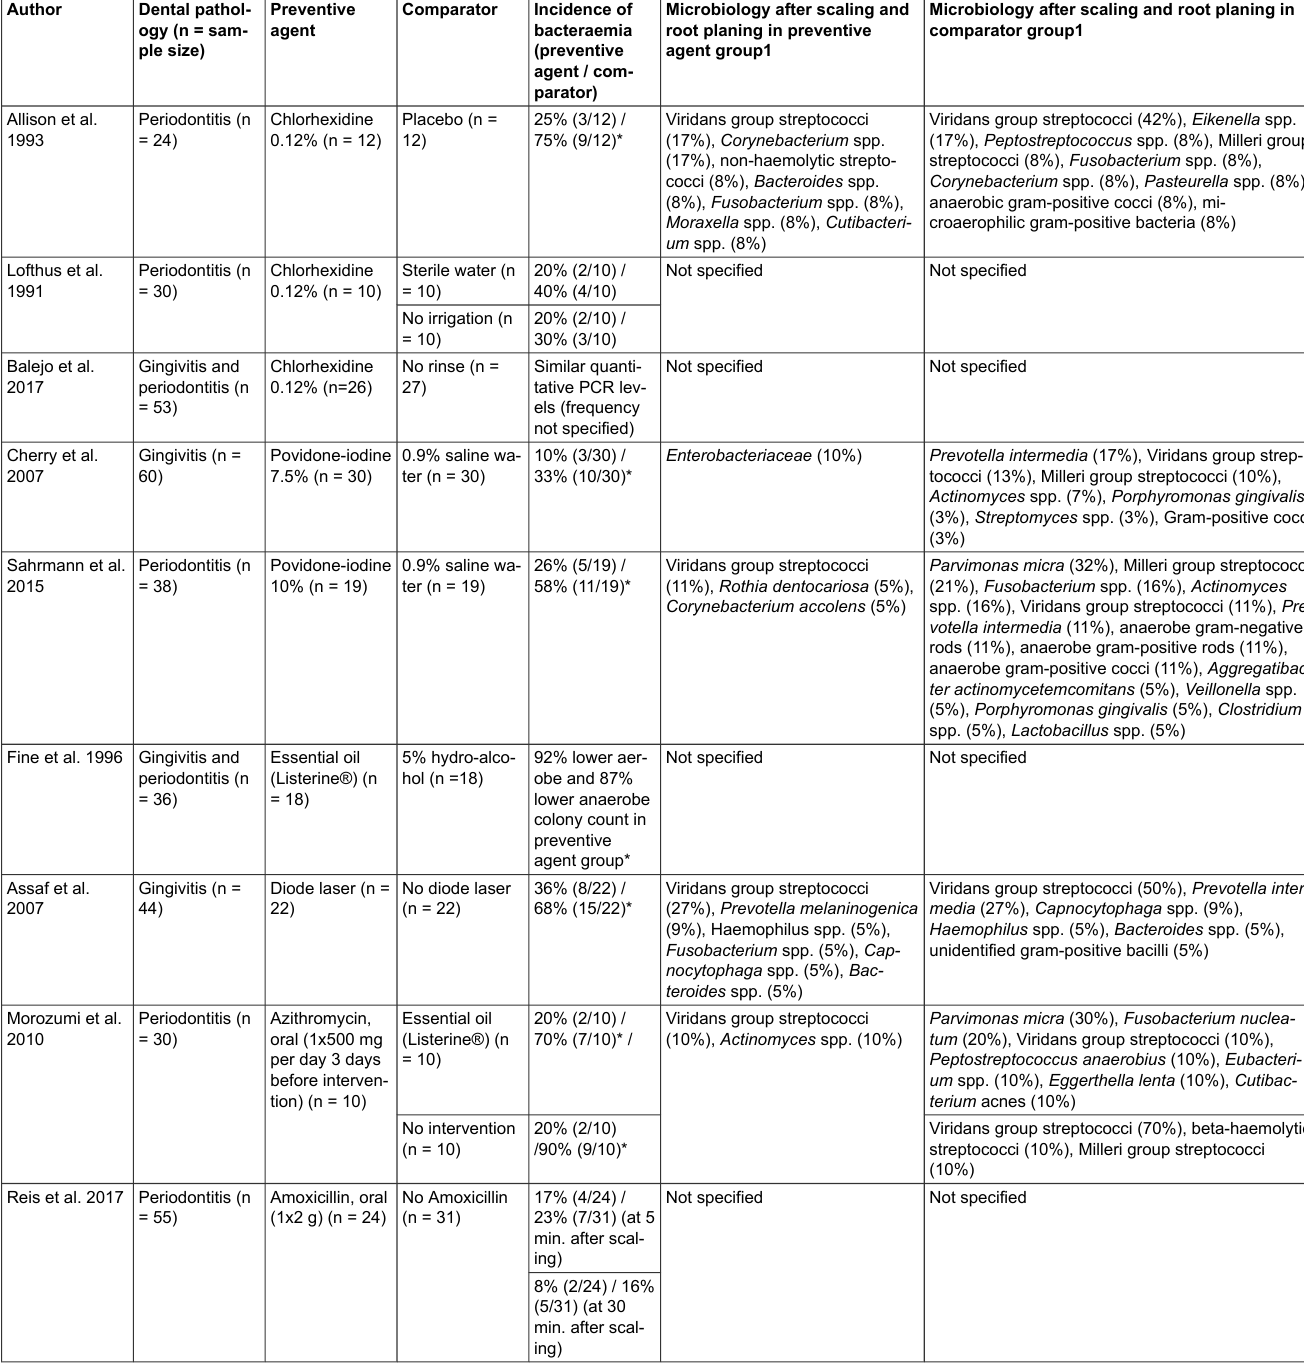
Table 2: Measures to decrease the risk of bacteraemia after periodontal treatment and pathogen distribution in cases of